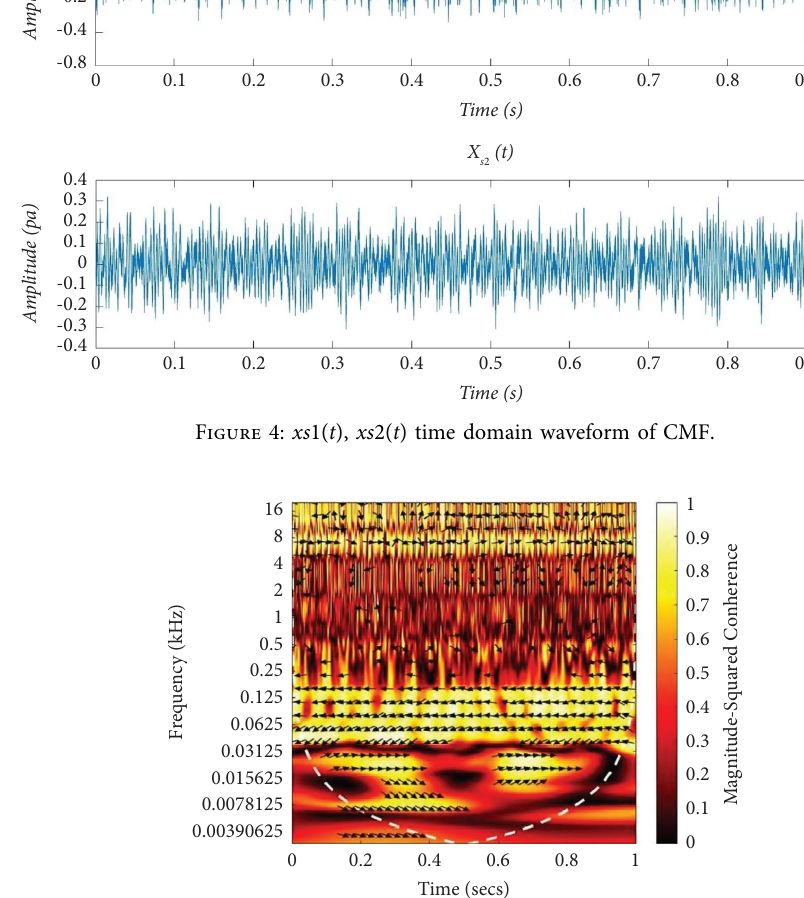
Figure 5: Wavelet coherence spectrum of